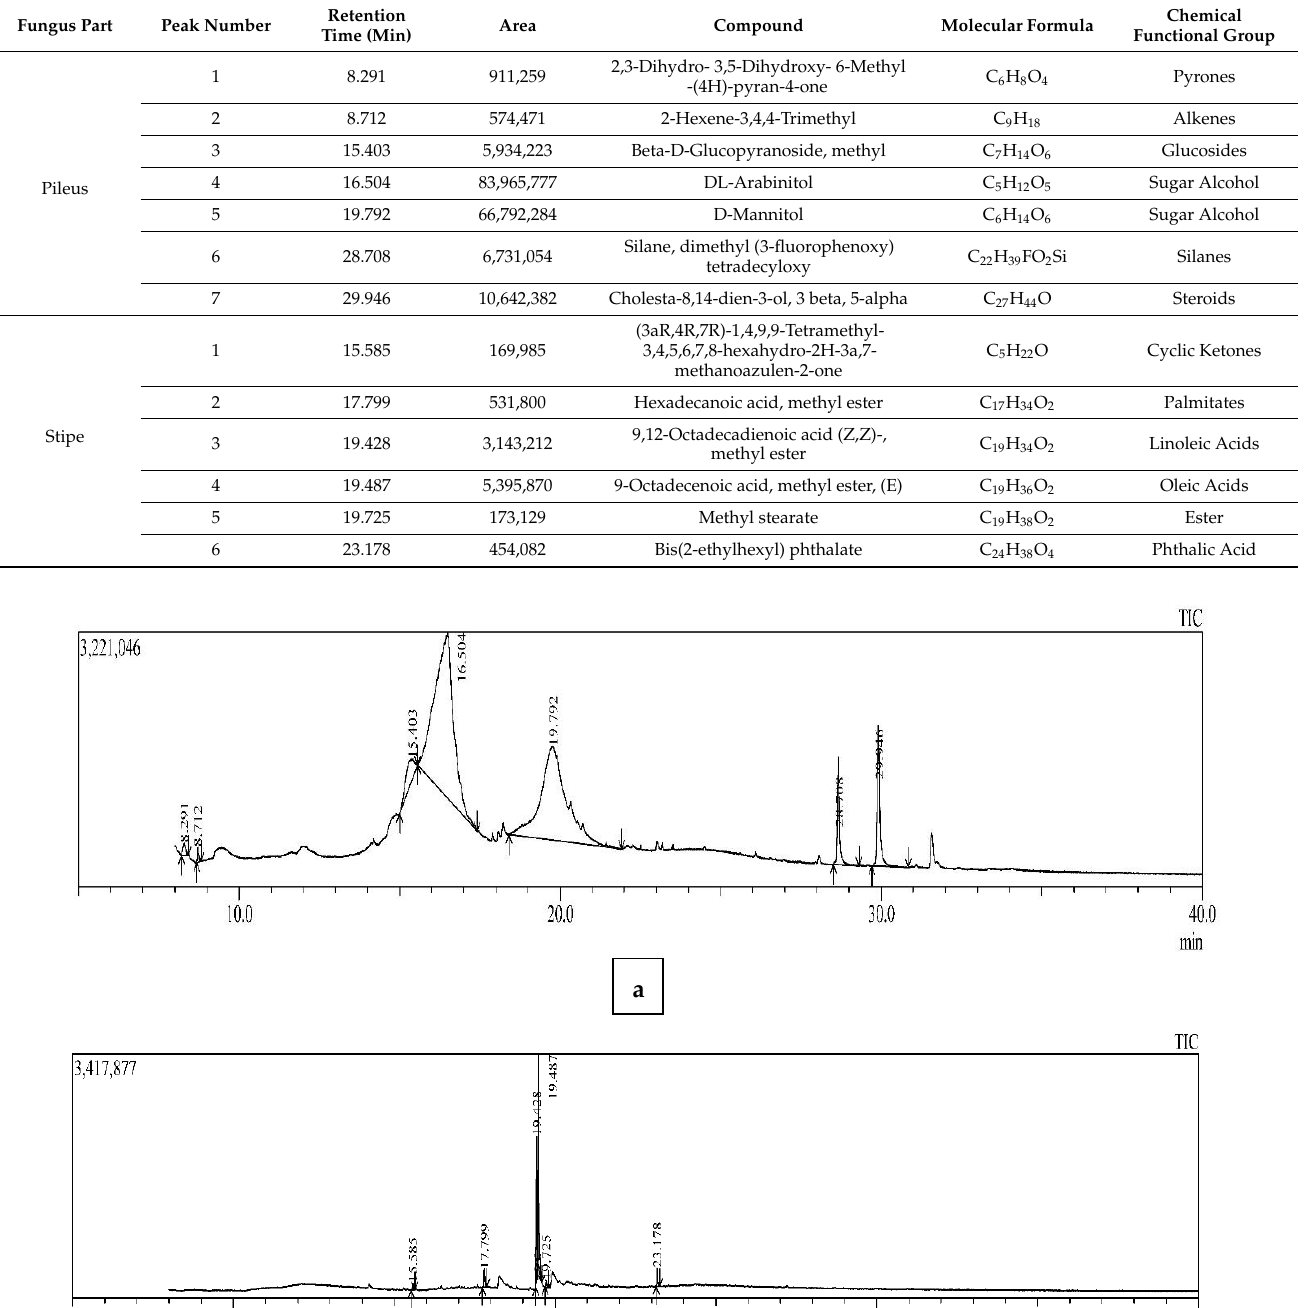
Table 5. The major compounds detected in the ethanolic extract of G. lucidum parts (pileus and stipe) by GC-MS analysis.